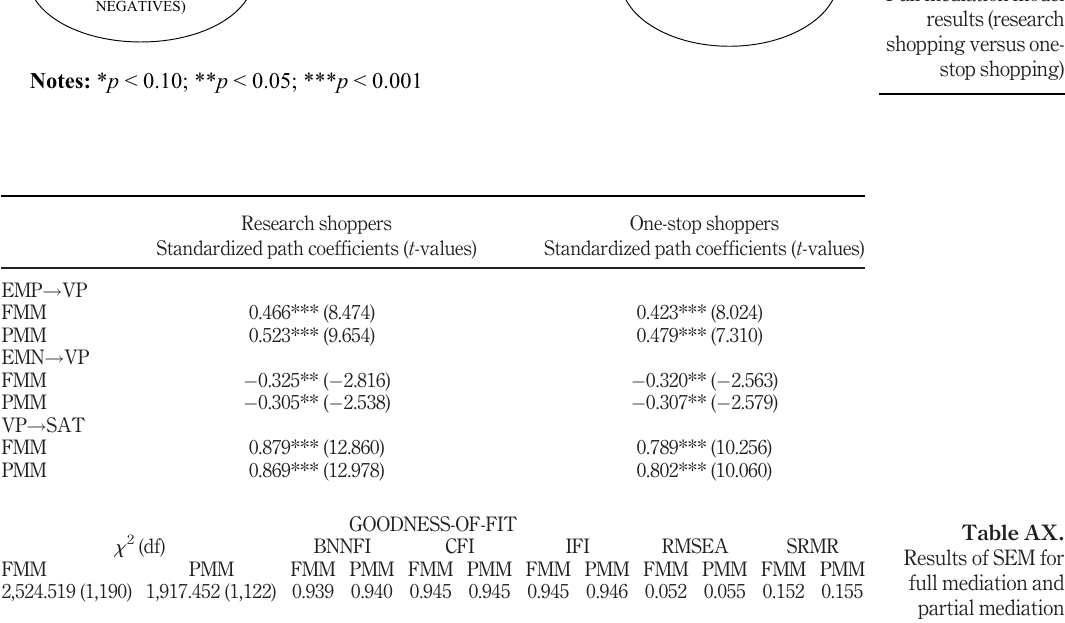
Figure A1. Full mediation model